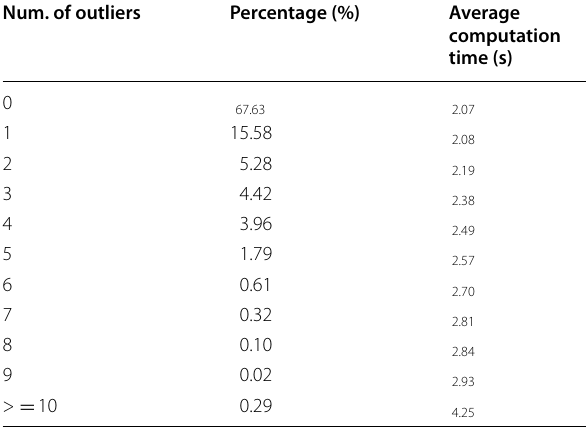
Table 2 Distribution of the number of detected outliers and the averaged computation time in June 2021 Num. of outliers